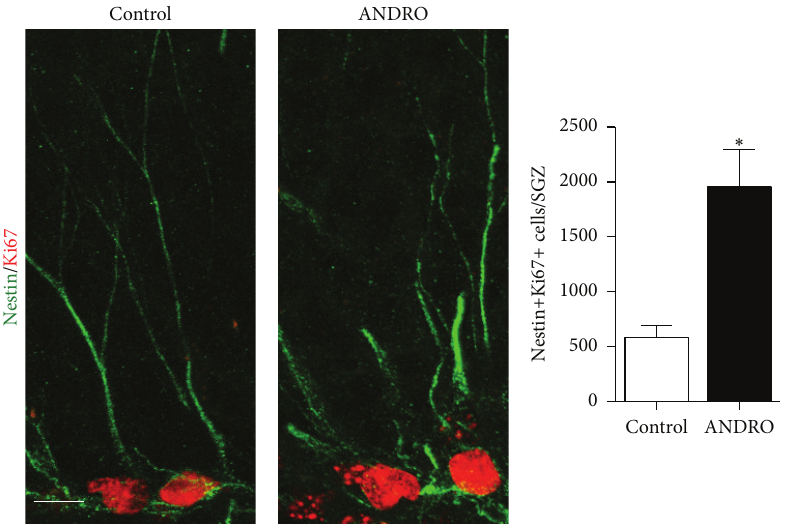
Figure 2: ANDRO induce proliferation of neural progenitors in the SGZ. Representative immunostaining of Ki67 and Nestin in 2-month old mice treated per 4 weeks with 2mg kg −1 ANDRO or saline solution as control. Scale bar: 10 𝜇 m. The graph represents quantification of the total number of Ki67-positive/Nestin-positive (Ki67+Nestin+) cells in the SGZ. Bars represent mean ± S.E. ( 𝑛 = 3 mice). ∗ 𝑃 < 0.05 , Student’s 𝑡